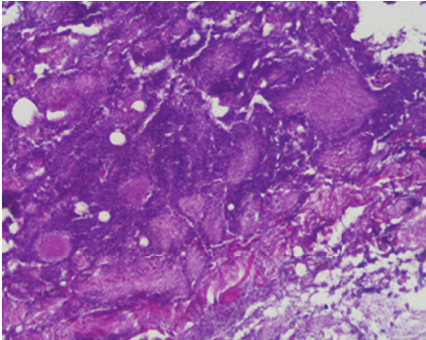
Figure 3: Hematoxylin-eosin stain 20x. Bacterial colonies situated inside the neutrophilic collections create characteristic structures called “sulfur granules.”